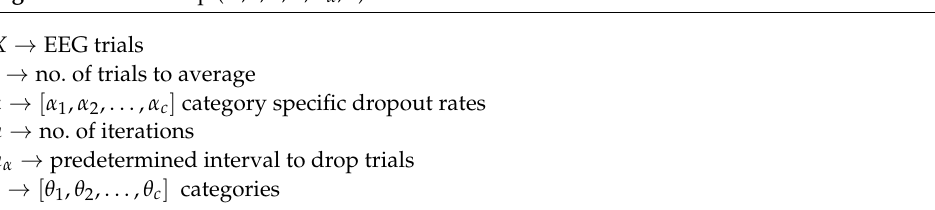
Algorithm 1 bootstrap ( X , r , α , n , n α , θ